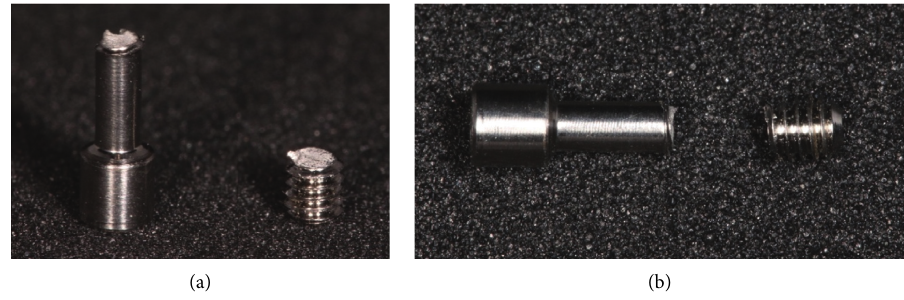
Figure 7: (a), (b) Fracture pattern of Iconekt ® screws.